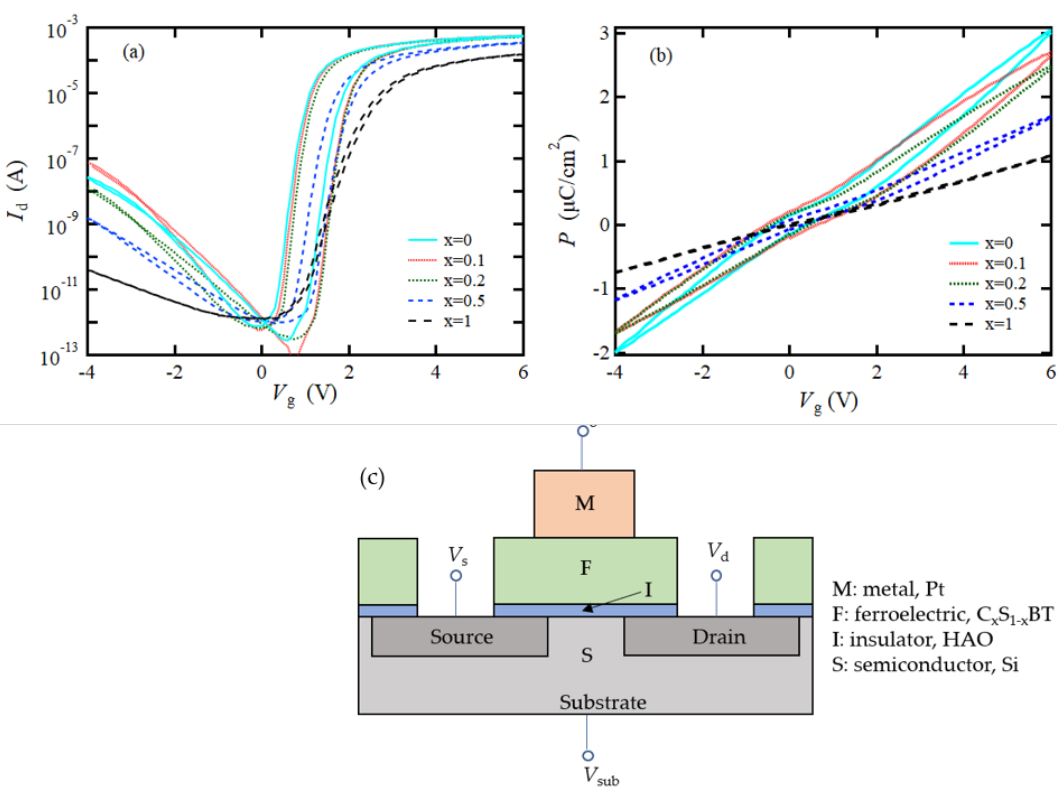
Figure 1. ( a ) Drain current ( I d ) vs. gate voltage ( V g )curves, modified from [19]; ( b ) Polarization ( P ) as a function of gate voltage of C x S 1–x BT ferroelectric-gate field-effect transistors (FeFETs) with x = 0, 0.1, 0.2, 0.5, and 1. C x S 1–x BT crystallization annealing were performed in O 2 ambient for 30 min at 813 ◦ C for x = 0 and at 800 ◦ C for the others. ( c ) Schematic drawing with voltage terminals for